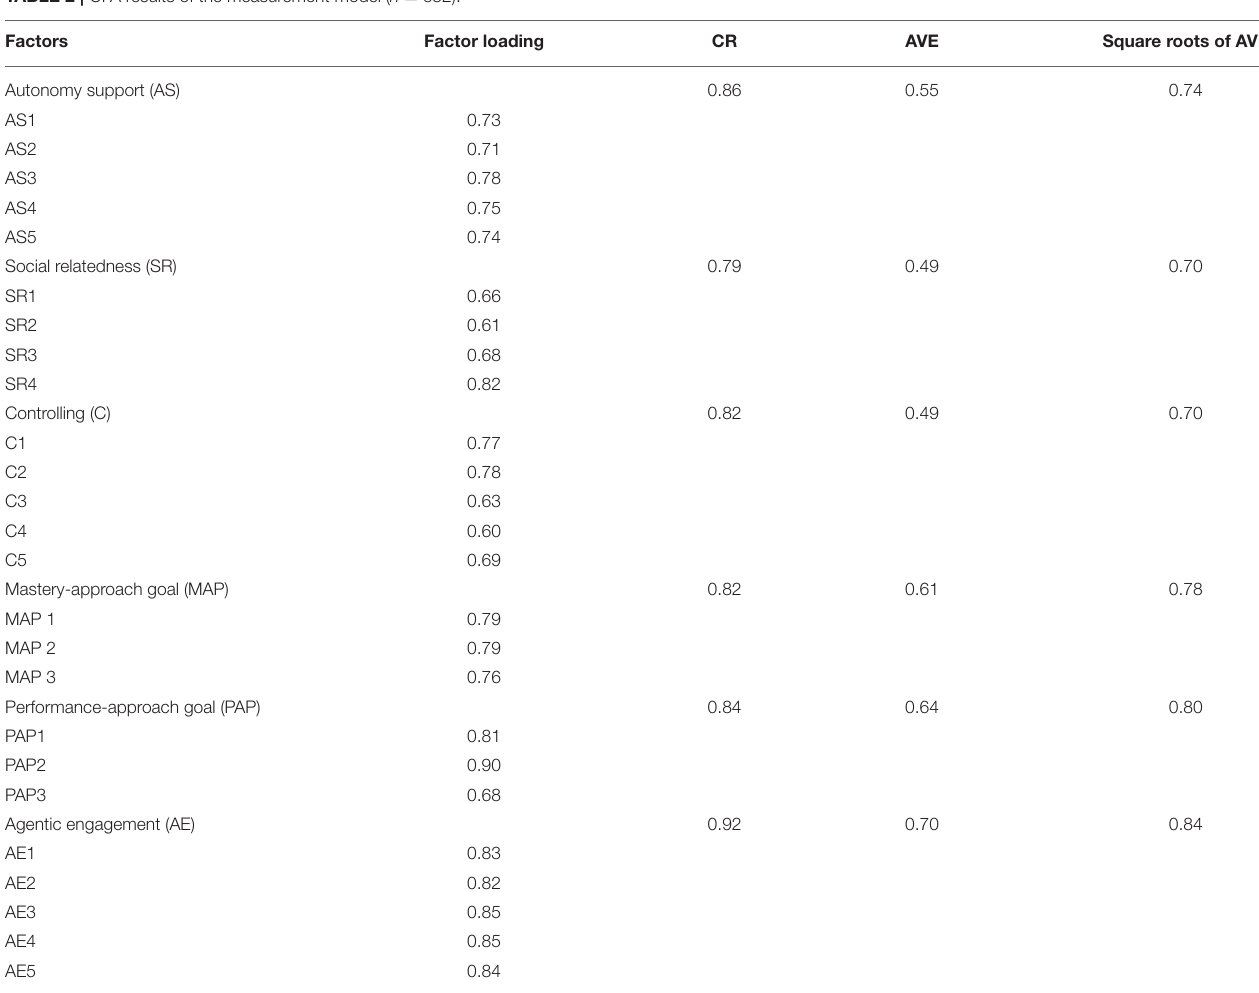
TABLE 2 | CFA results of the measurement model ( n = 632).